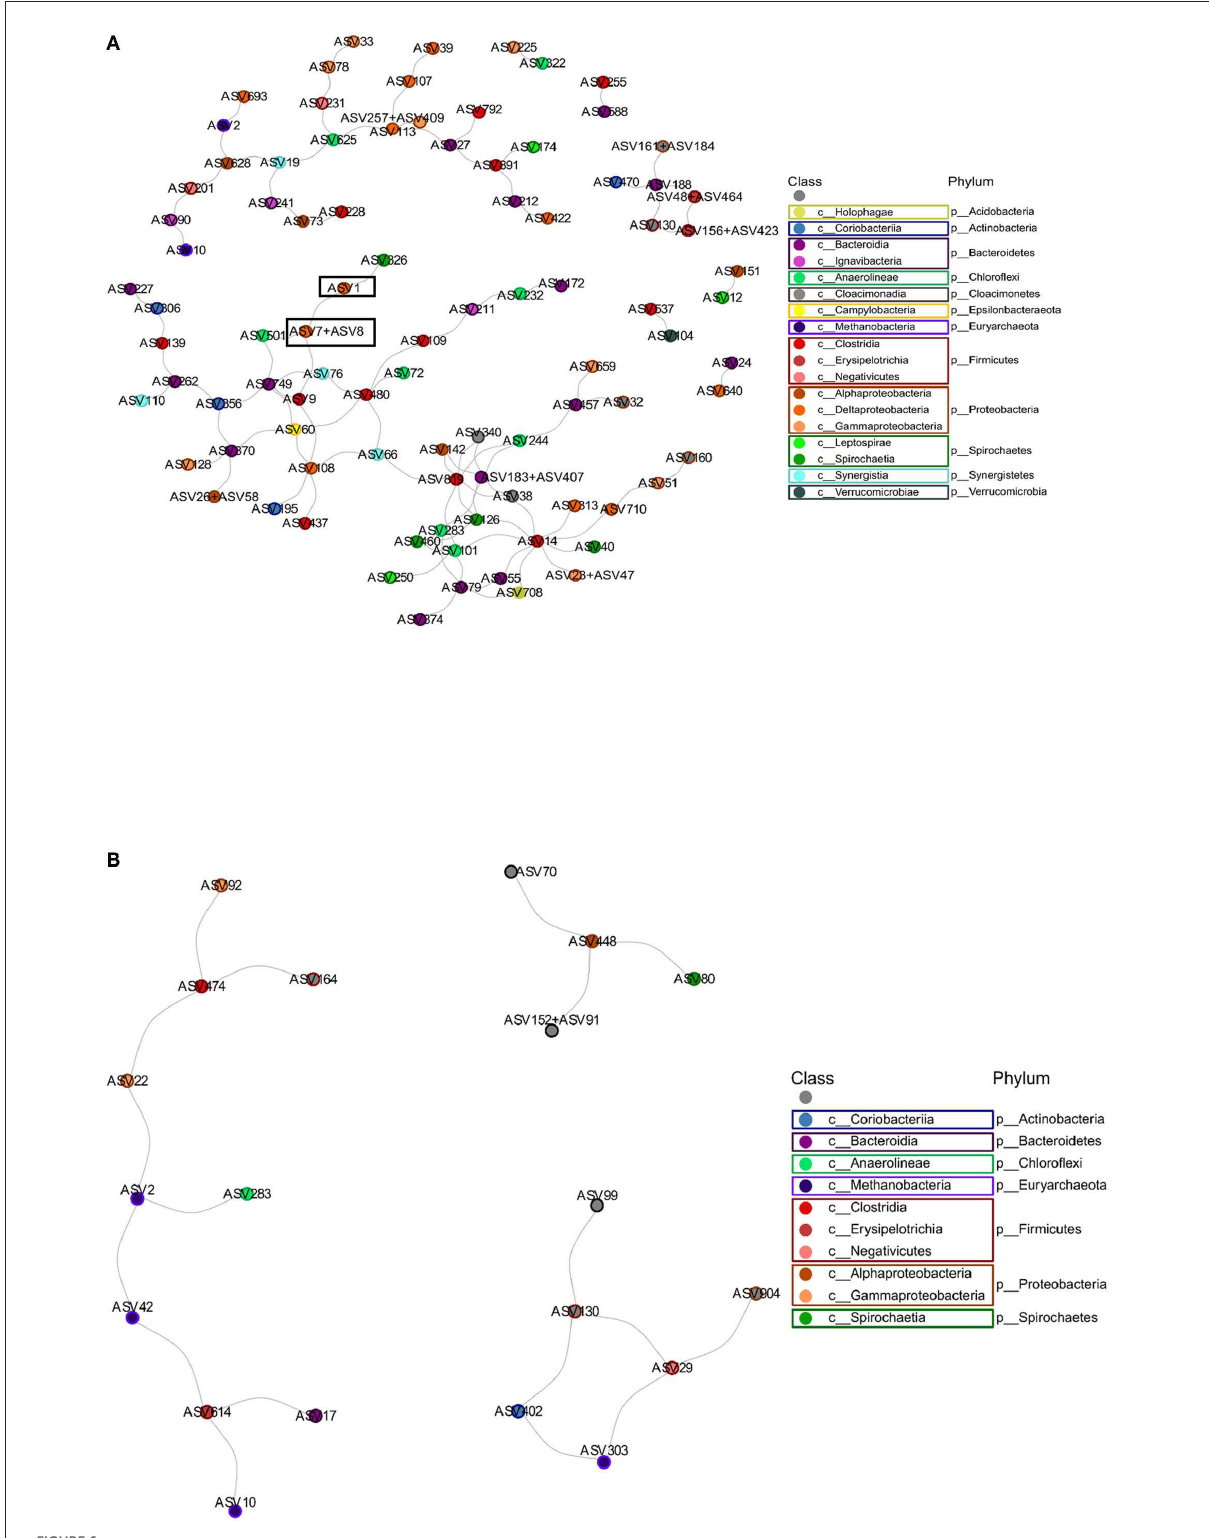
FIGURE6 The microbial correlation network depicting the negative interactions. (A) The anode microbial community. The interaction between ASV1 and the combination of ASV7 and ASV8 is highlighted. (B) The cathode microbial community. Colors depict the taxonomy of each ASV at the class